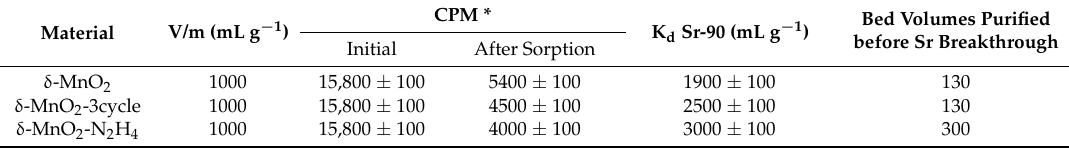
Table 3. Sorption performance of studied birnessite materials with respect to